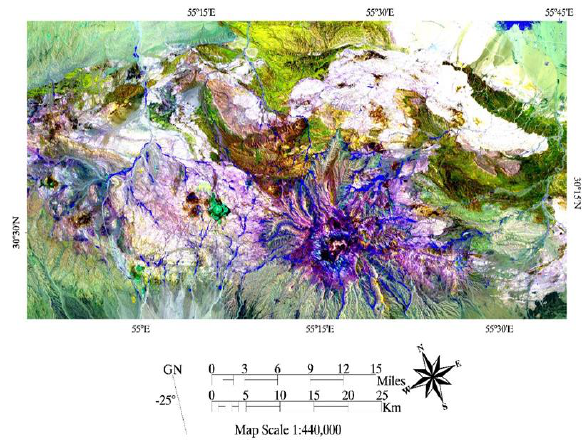
Figure 4. FCC image of RGB=(5*6)/7, (4*6)/(5*2), (5*6)/(7*2) shows altered rocks as black spots, also cyan color indicates mining sites, Meiduk mine is distinguished with a cyan color spot in the center of scene. Table 1. Eigenvector lodgings table for DSPCA eigenvalues, calculated from Shahr-e-Babak OLI data for mapping argillic